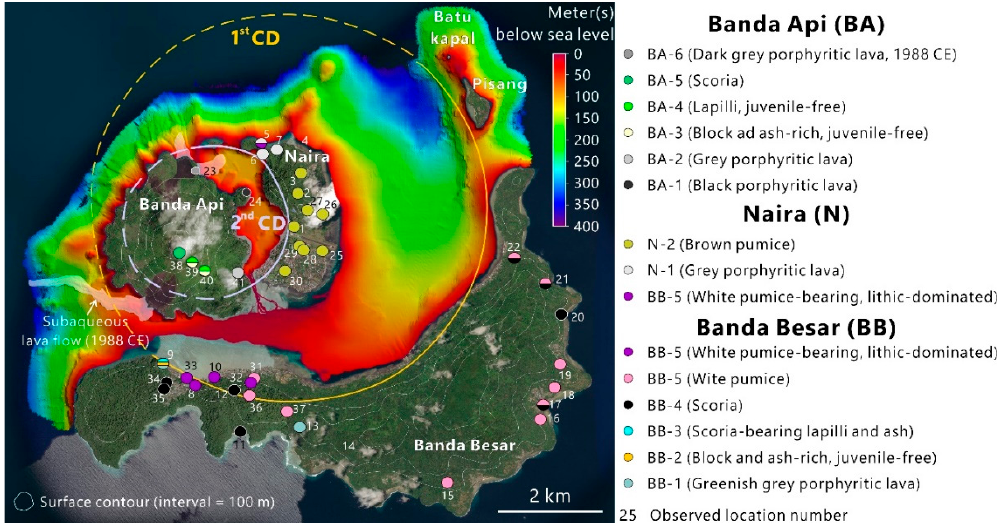
Figure 2. Circles represent the sampling locations of this study (LOC; note that each circle’s color corresponds to a different eruptive unit). Yellow and blue lines highlight the estimated boundary of the first and second circular depressions (CD). The data source of the bathymetry and satellite images is the Pusat Hidro-Oseanografi Tentara Nasional Indonesia Angkatan Laut (PUSHI-DROSAL).